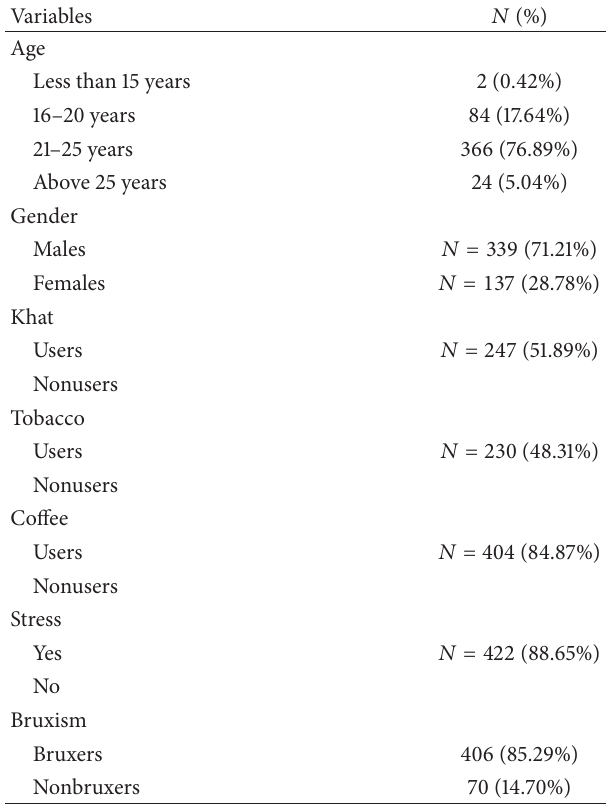
Table 1: Distribution of the participants according to the variables